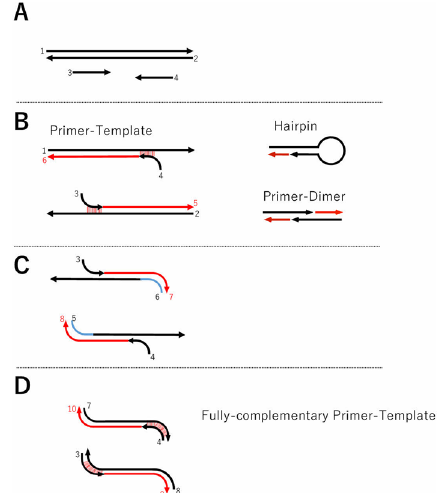
Figure 1. PCR process diagram of primers with incomplete homology with the template. Schematic diagram of the reaction assumed by PCR from partially matched primers. DNA elongation may start from primers on which partially 3 ′ -end matches ( B ). On the end of second cycle, the 3 ′ -end of the elongated DNA completely match with a primer ( C ). On the end of third cycle, synthesized DNA are completely matched on both ends of synthesized DNA ( D